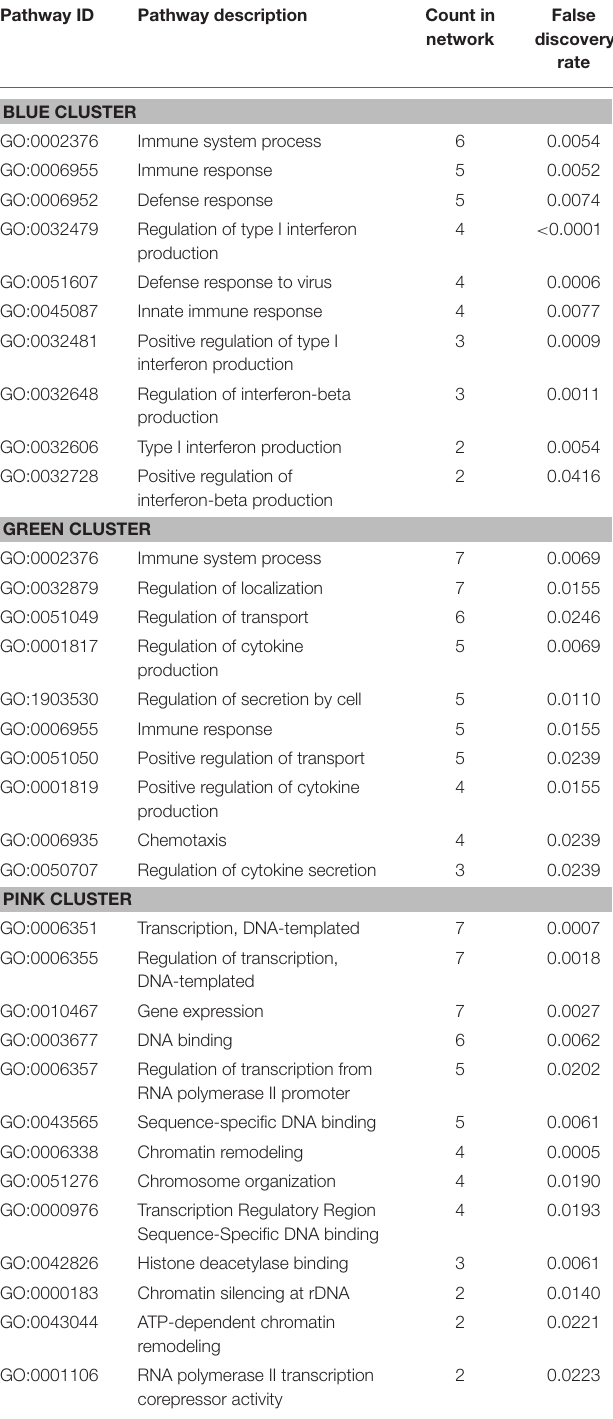
TABLE 4 | GO Biological processes and molecular functions of PPI-clusters from downregulated mRNAs in α -Gal ( − / 0) vs. wildtype mice. Pathway